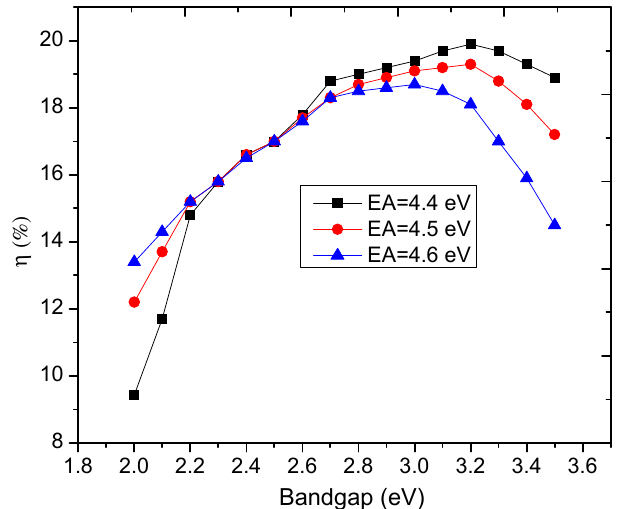
Figure 5. Effect of electron affinity of ZnO (bandgap: 3.27 eV) on the V OC and I SC of n-ZnO/p-Si solar cell using PC1D simulations.